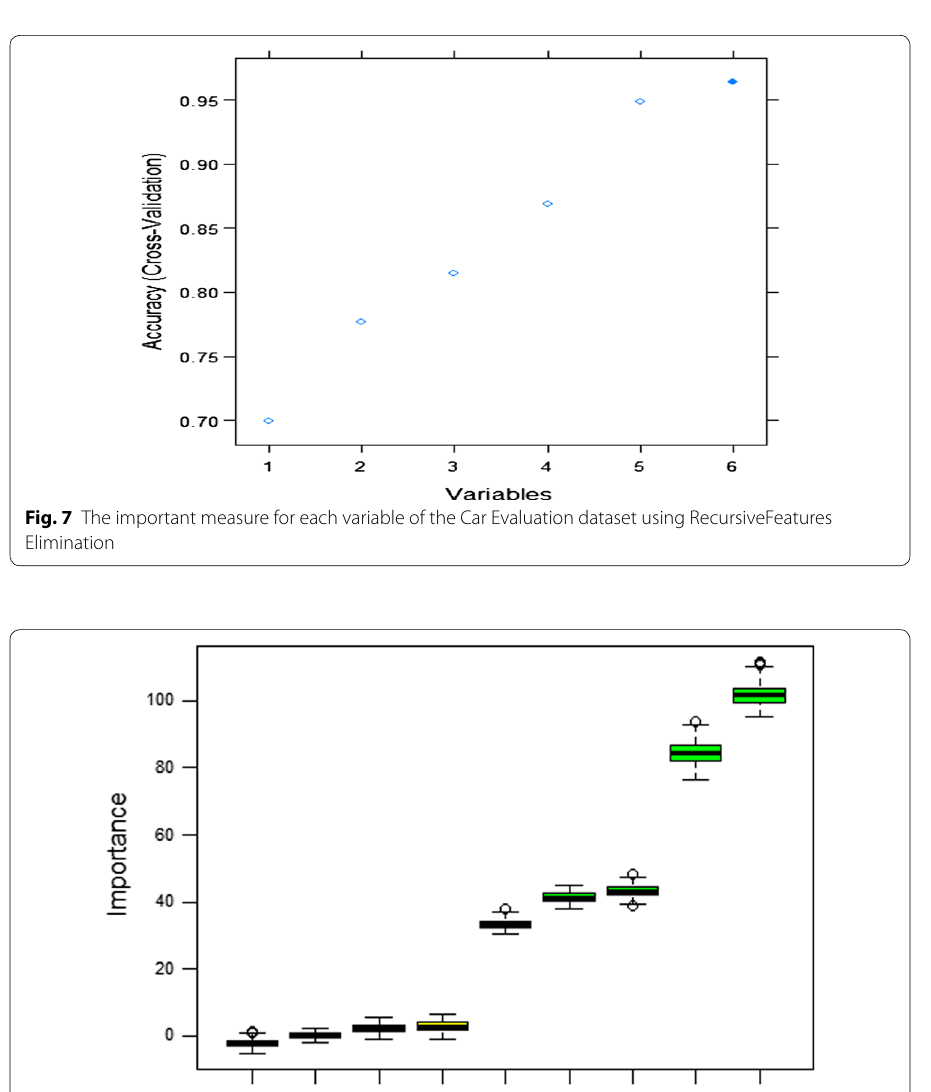
Human activity recognition using Smartphones dataset